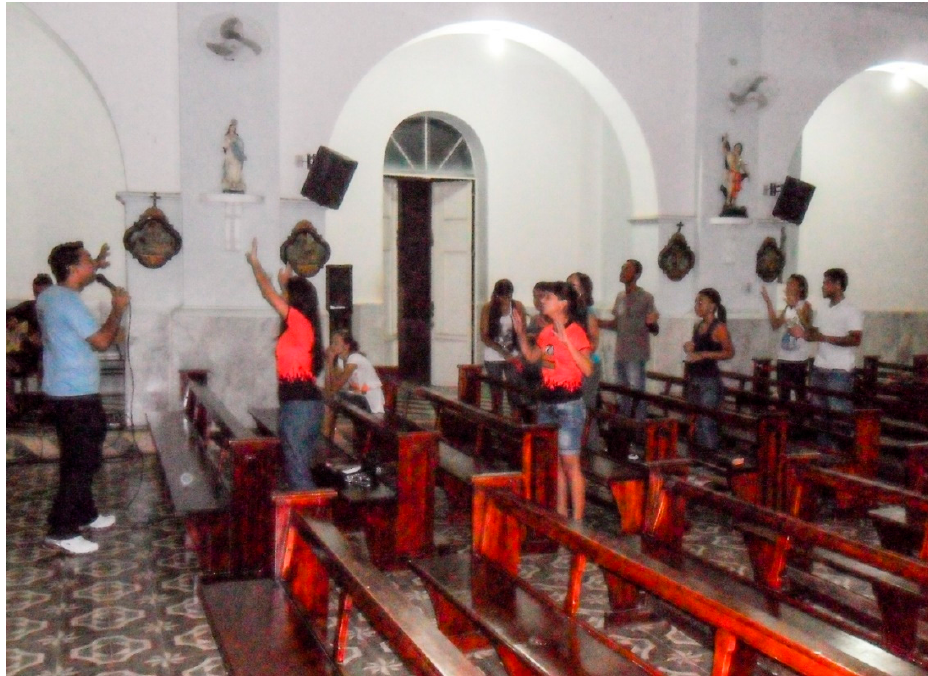
Figure 1. Source: Research collection: Charismas and Institutions—The Crisis of Catholicism in the state of Rio de Janeiro and the Paradoxical Advancement of New Religious Communities. Author: Sílvia Fernandes—Meeting of the Aliança de Misericórdia Prayer Group. 2012. 16 .